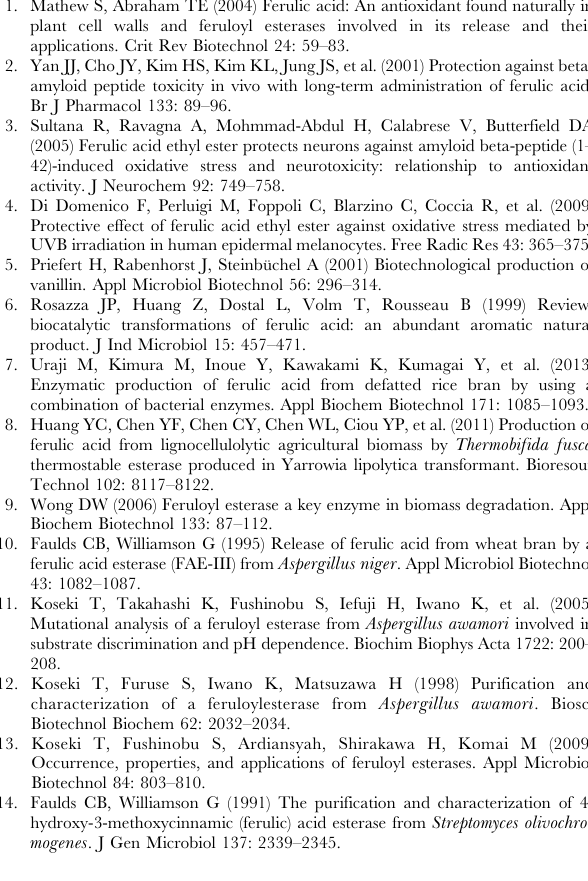
Figure S1 Multiple alignment of R18 and homologues from Streptomcyes sp. Amino acid sequences were aligned by GENETYX software (Tokyo, Japan) and the amino acid residues matched more than three are indicated in black boxes. (TIF) Figure S2 Multiple alignment of R43 and homologues from Streptomcyes sp. Amino acid sequences were aligned by GENETYX software (Tokyo, Japan) and the amino acid residues matched more than three are indicated in black boxes. (TIF) Figure S3 Time course of R18 and R43 FAE activity. Averages of three independent experiments are shown. Error bars represent